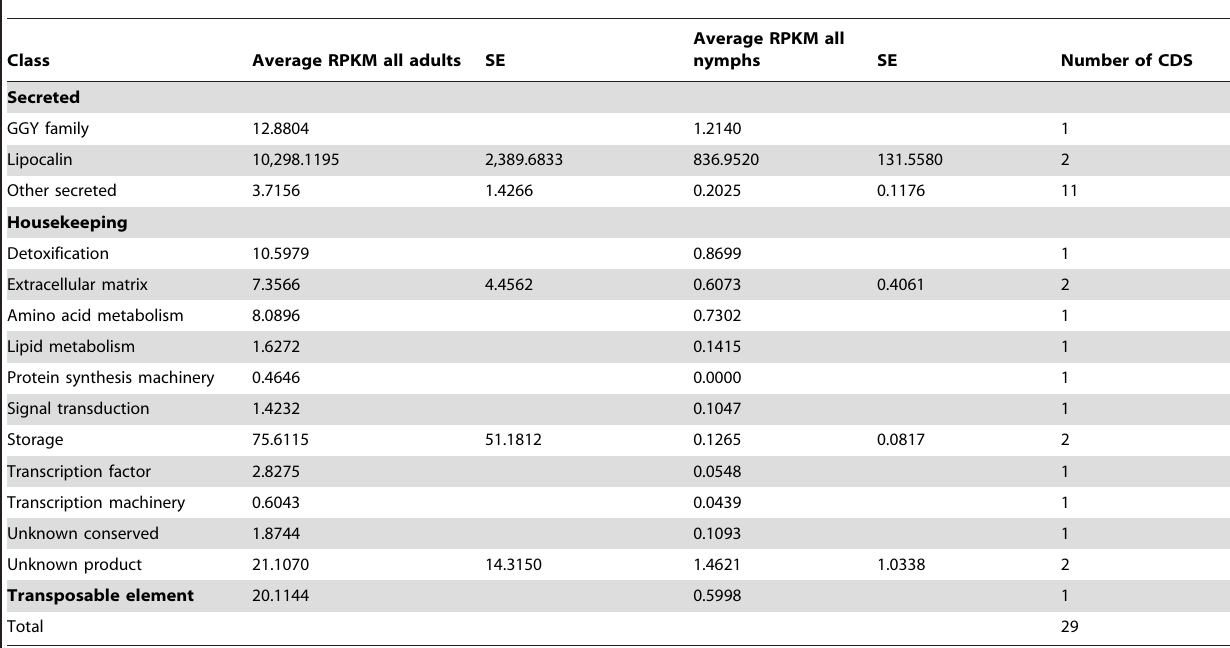
Table 6. Classification of coding sequences at least 10 6 overexpressed in adult libraries when compared to nymphal libraries.